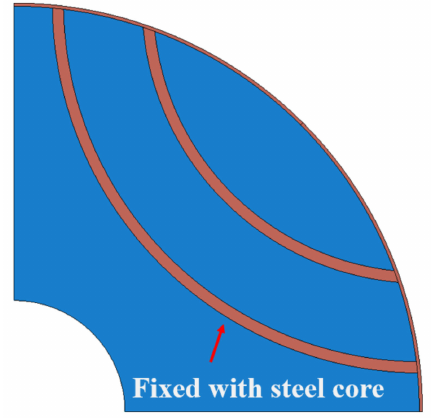
Figure 5. Example of inserting steel